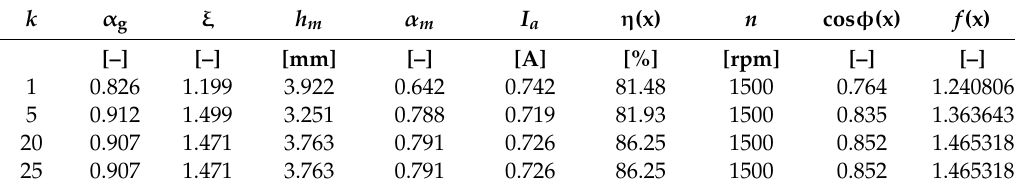
Table 3. Results of optimization calculation for selected iteration of optimization